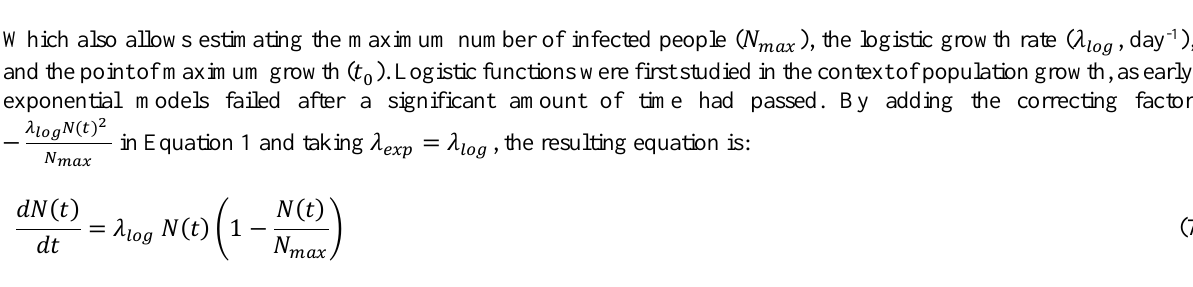
-1 ), 𝒎𝒂𝒙 = 𝟏𝟎𝟎 , 𝑵 𝟎 = 𝟏 , 𝝀 𝒍𝒐𝒈 = 𝟎.𝟐 (day